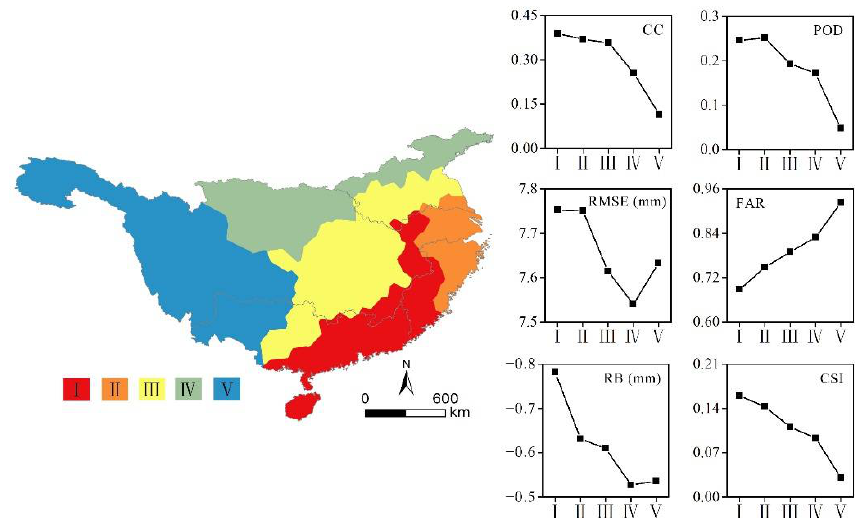
Figure 5. Regional division and evaluation indices of each zone.